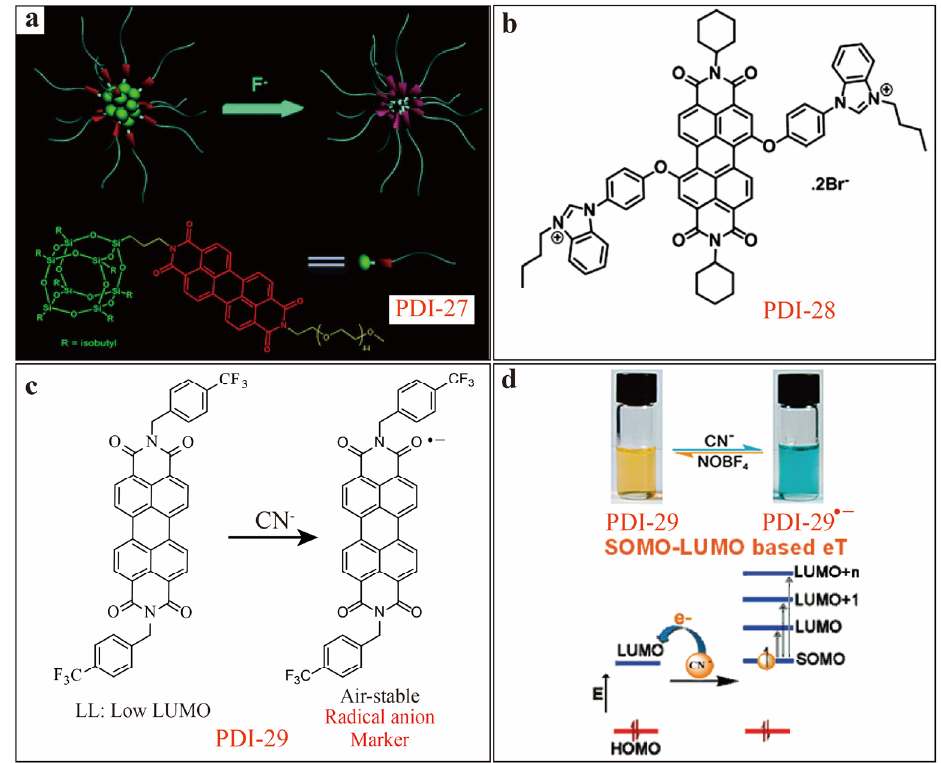
Figure 9. ( a ) Schematic illustration of the F − induced self-assembly of PDI-27 polymeric nanoparticles in water. Reproduced with permission from [39], copyright 2013 Royal Society of Chemistry. ( b )